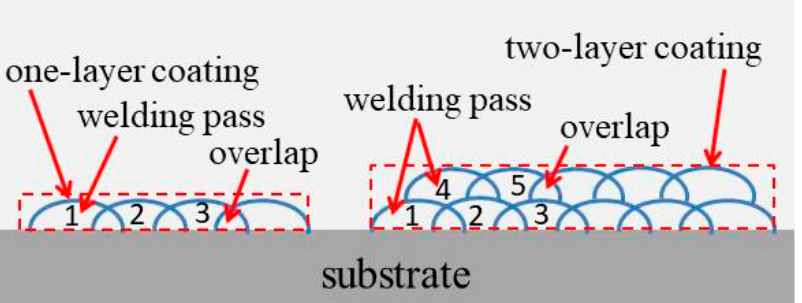
Figure 1. Process diagram of surfacing welding coating preparation.